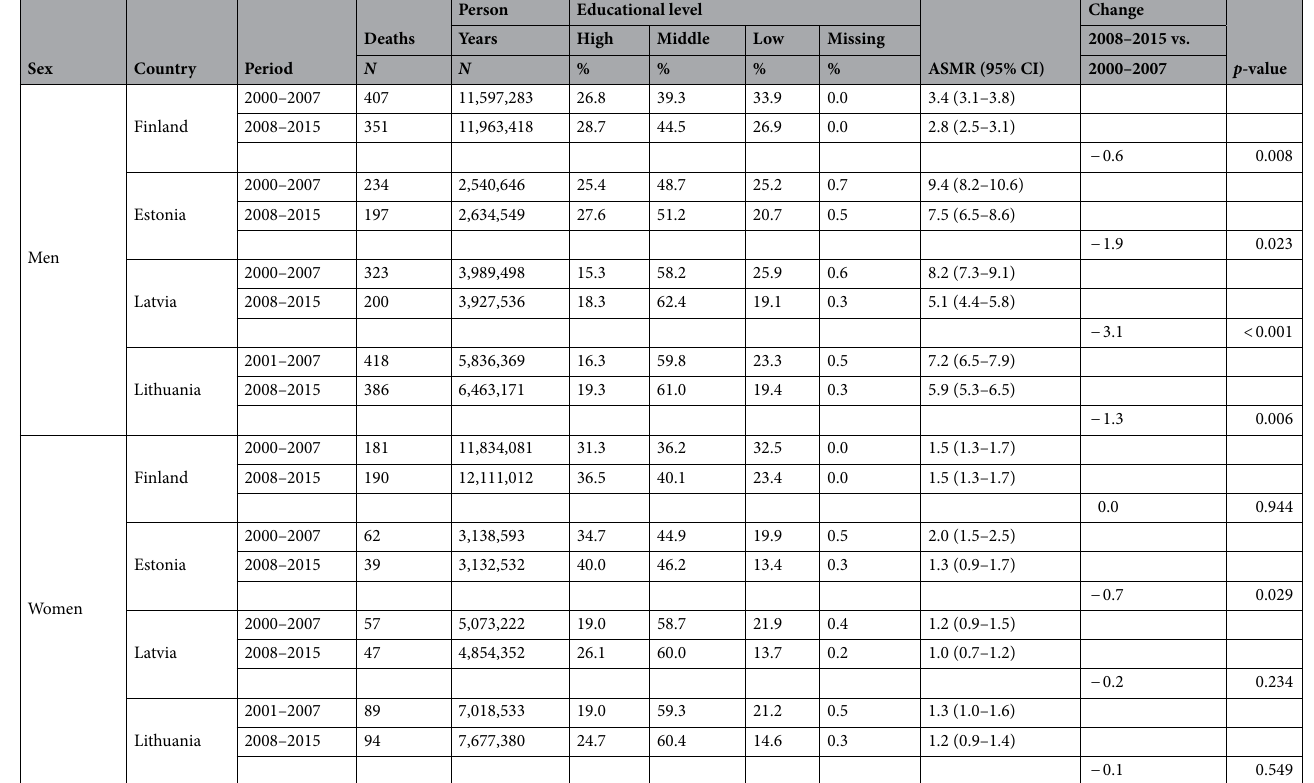
Table 1. Characteristics of the study populations and age-standardised mortality rates per 100,000 person years for epilepsy in 2000–2015 in the 30–74 age group. The follow-up in the 1st period started from the census date in the Baltic countries, i.e. 31.03.2000 in Estonia, 1.03.2000 in Latvia, and 6.04.2001 in Lithuania; in 2008 the follow-up started on January 1; the follow-up ended on December 31 in the respective periods. ASMR age- standardised mortality rate per 100,000 person years, CI confidence